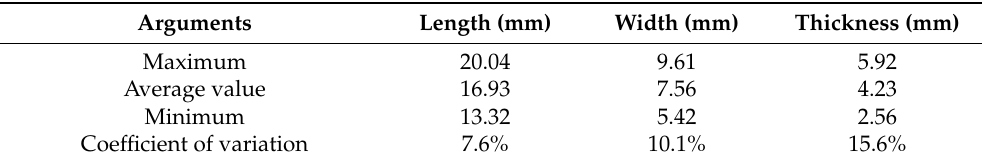
Figure 3. Schematic diagram of the triaxial dimensional structure of the seed. Table 1. Triaxial size of sunflower seeds.